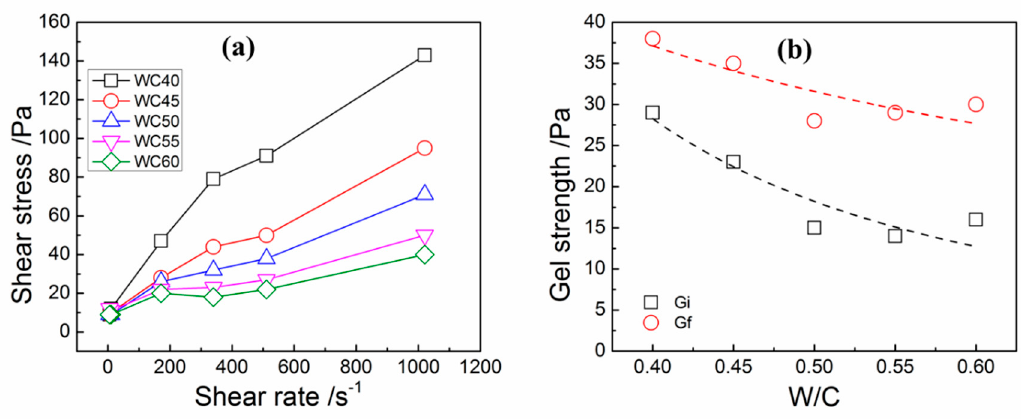
Figure 3. Plots of shear stress versus shear rate for neat OWC slurries ( a ) and their gel strengths ( b ) at different WCRs.